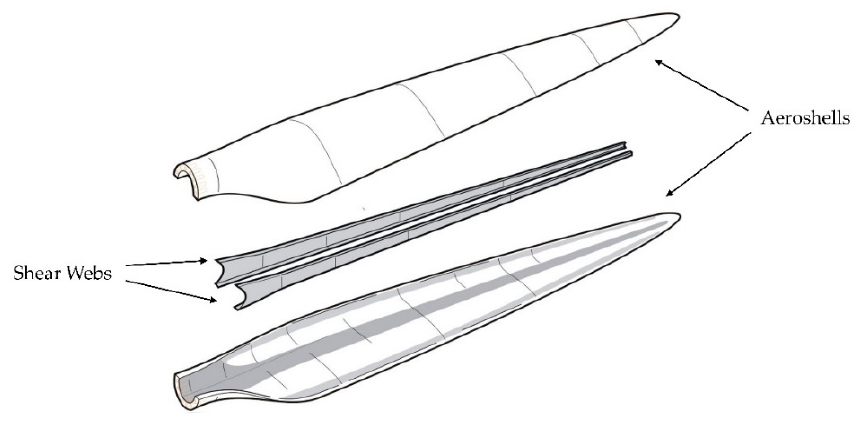
Figure 1. Schematic of the manufacturing of a wind turbine blade [12].